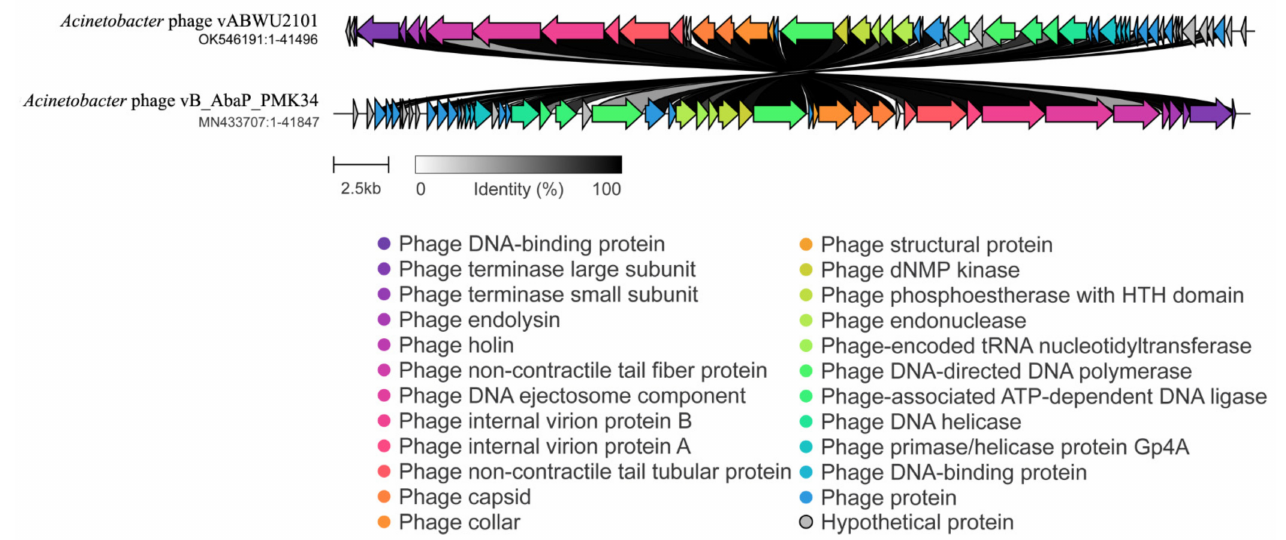
Figure 3. Map of the genome organization of phage vABWU2101. Visualization was performed by using Clinker. The coding sequences of phage vABWU2101 were compared with Acinetobacter phage vB_AbaP_PMK34, the most closely related phage. Homologous coding sequences are in the same color, and the homologous coding sequences between phage vABWU2101 and phage vB_AbaP_PMK34 are linked through gray bars with the percentage amino acid identity. The identity is represented by gray bars, with darker shades of gray indicating higher percentage